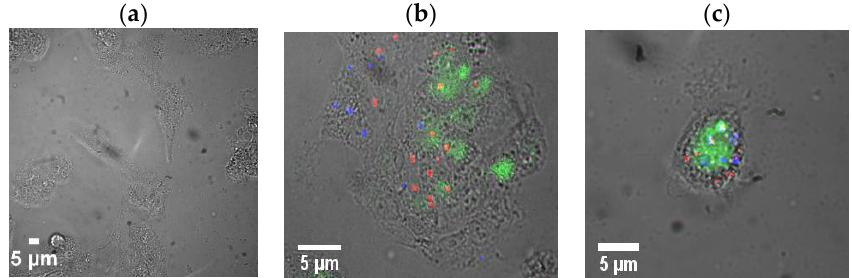
Figure 5. Brightfield/fluorescence overlay images of ( a ) untreated control HepG2 cells and ( b , c ) cellular uptake of (7,5) sorted SWCNTs imaged at 1030 nm (red), (7,6) sorted SWCNTs imaged at 1130 nm (blue), and PX-866 imaged at 535 nm (green) after the intracellular release.